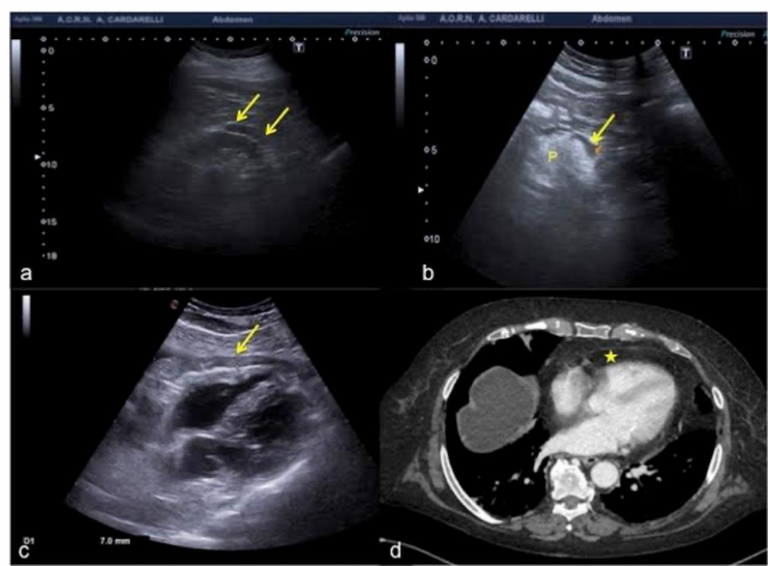
Figure 21. ( a ) Hypoechoic peri-renal fat, ( b ) peri-pancreatic fat and ( c ) pericardial fat misinterpreted as fluid collections (arrows). ( d ) On CT scan pericardial fat was clearly visible without any fluid collection (star) unlike what was wrongly diagnosed on US scan ( c ). P: